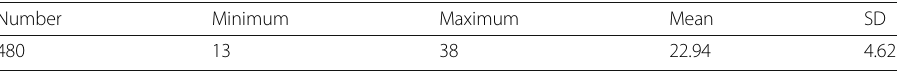
Table 3 Descriptive statistics for the proficiency test Number Minimum